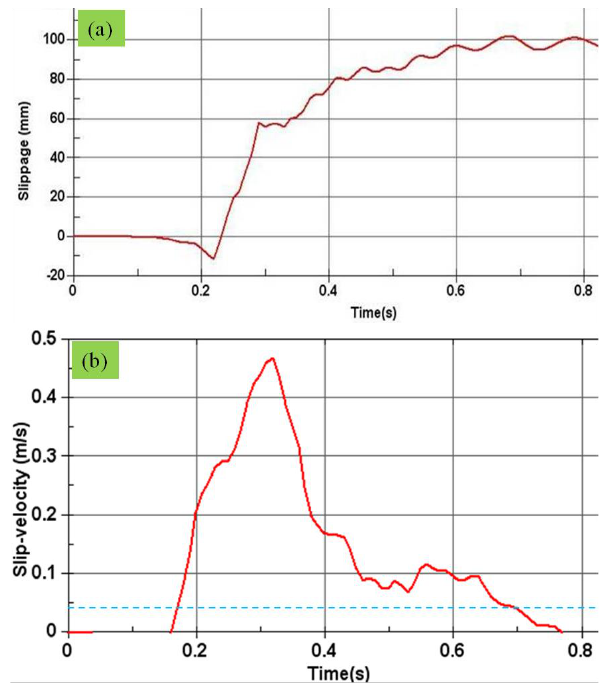
Fig. 14. Numerically simulated time histories of maximum slip-displacement (slippage) of the UFD device (at location M in Fig. 1) corresponding to the FST scenario of the R-LPR (a) and of the slip-velocity obtained by differentiating the slip-displacement w.r.t. time (b). The dotted (blue) horizontal line marks the assumed threshold slip-velocity of 0.04 m/s only below which the coefficient of dynamic frition varies significantly.